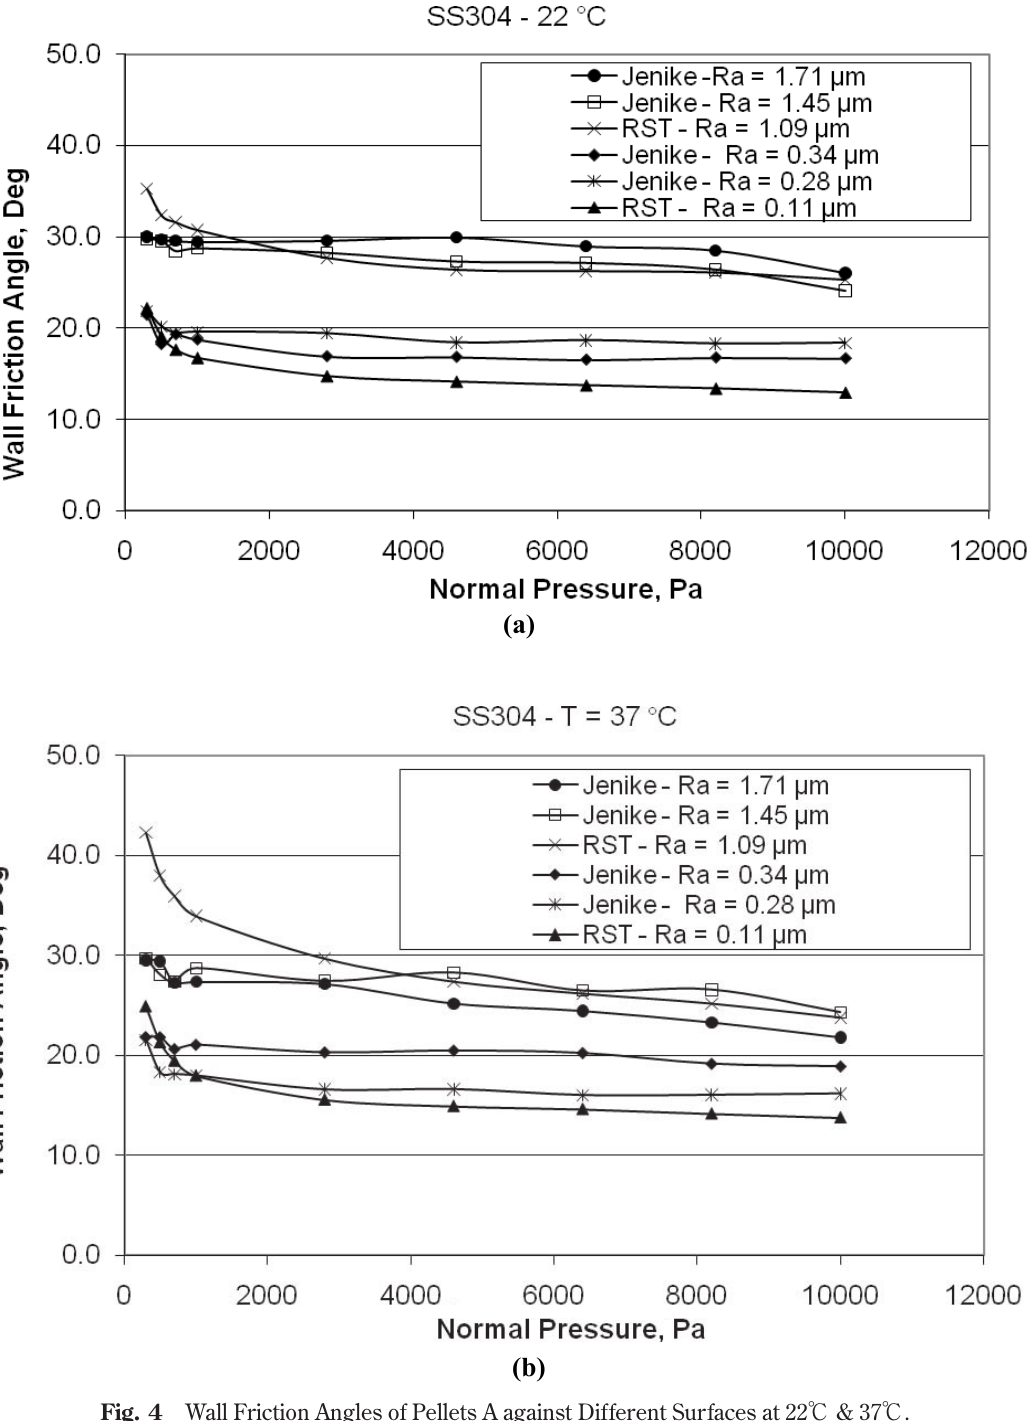
Fig. 4 Wall Friction Angles of Pellets A against Different Surfaces at 22 ℃ & 37 ℃